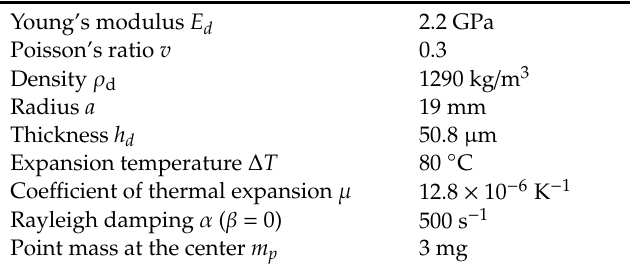
Figure 3. Finite element model (FEM) model and simulation results. ( a ) FEM model in COMSOL. ( b ) Mode shape (fundamental) for the three cavity lengths ( l = 0.3 mm, 3 mm, and 20 mm) obtained using an eigenfrequency study in the COMSOL Pressure Acoustics (PA) module. ( c ) Mechanical sensitivity as a function of frequency for the three cavity lengths obtained using (PA, solid line) and the Thermoviscous Acoustics (TA, dashed line) module. ( d – g ) Field distribution of the magnitudes of the velocity in the normal / z-direction (top), the velocity in the tangential / radial direction (middle), and the acoustic pressure (bottom) for four cases: ( d ): PA, l = 0.3 mm; ( e ) TA, l = 0.3 mm; ( f ) PA, l = 20 mm; and ( g ) TA, l = 20 mm. The frequency for all cases in ( d – g ) was 1.3 kHz. Table 1. Properties of the polyimide